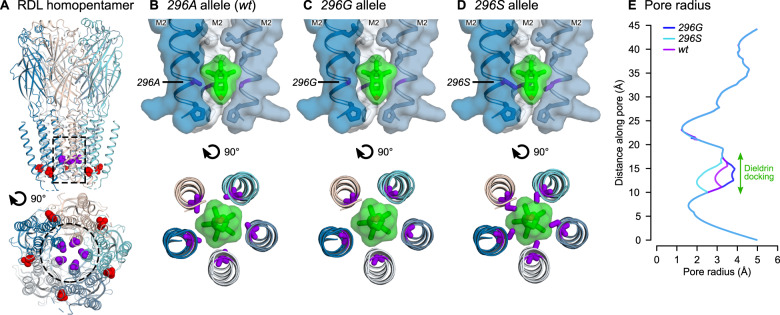
RDL receptor models with docked dieldrin. (A) Homology model of the Anopheles gambiae RDL homopentamer, viewed from the membrane plane (top) and cytoplasm (bottom). The 296A (purple) and 345T (red) positions are shown in space-fill. The dotted outlines depict the receptor regions in panels (B–D). (B) Docking prediction for dieldrin in the pore of the 296A (wt) receptor. Dieldrin is shown in green, in sticks, and transparent surface. Side chains lining the pore are shown as sticks and 296A is colored purple. (C and D) Superimposition of dieldrin docking onto models of the 296G and 296S receptors, respectively. (E) Pore radii in 296A, 296G, and 296S models.